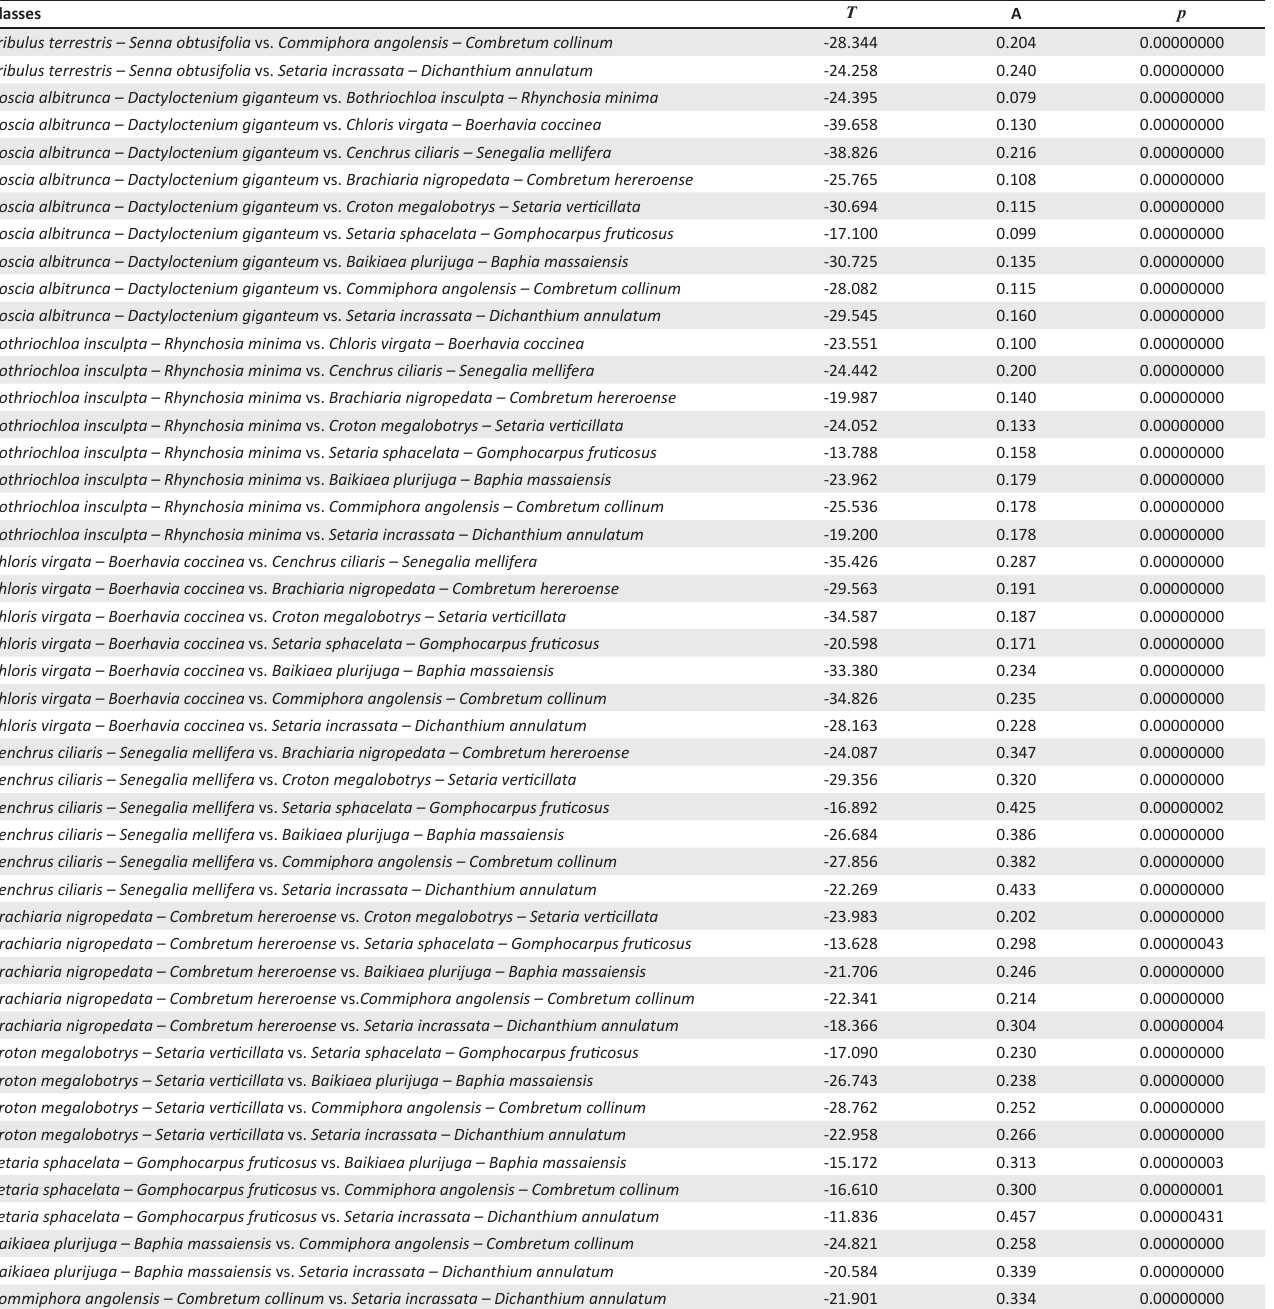
TABLE 1-A1 (Continues...): Multiresponse permutation procedure pairwise comparisons between identified classes for plant communities in the Savuti-Mababe-Linyanti ecosystem (northern